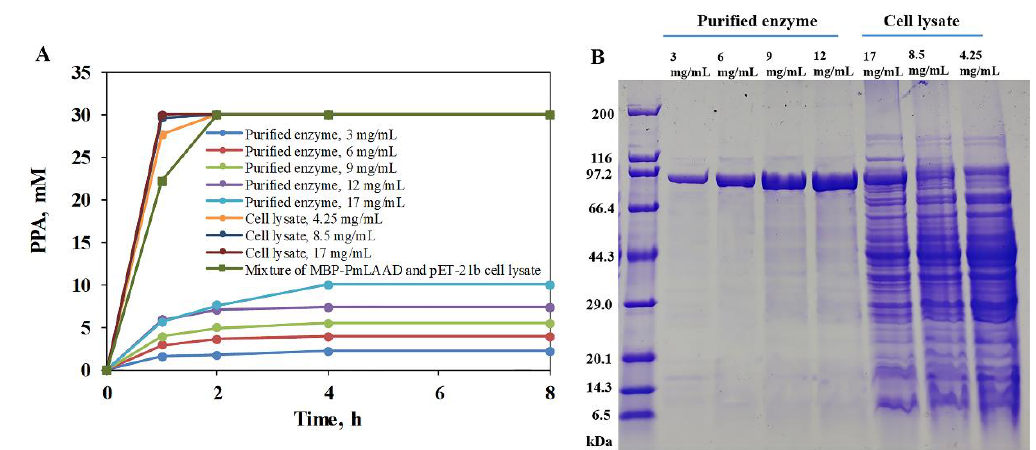
Figure 4. The effect of biocatalyst concentration and E. coli BL21 (DE3)/pET-21b cell lysate on the catalytic efficiency. ( A ) The catalytic conversion of L-Phe to PPA with different concentrations of the MBP-PmLAAD purified enzyme and cell lysate. The mixture of the MBP-PmLAAD and pET-21b cell lysate was composed of 3 mg/mL purified MBP-PmLAAD and 50 mg/mL E. coli BL21 (DE3)/pET-21b cell lysate. ( B ) The SDS-PAGE analysis of different concentrations of the MBP-PmLAAD purified enzyme and cell lysate. The reactions were all conducted in a 50 mM, pH 8.5 Tris-HCl buffer at 37 °C. 2.4. Conversion of L-Phe to PPA with MBP-PmLAAD Cell Lysate